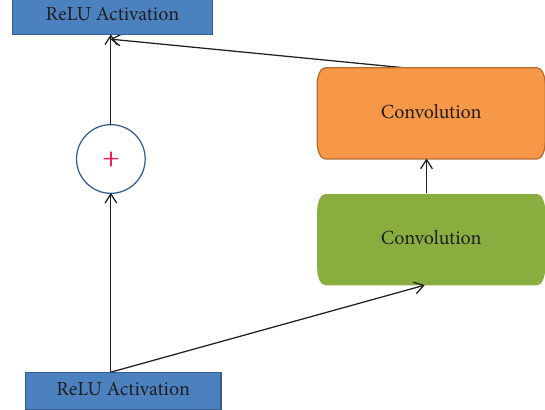
Figure 3: Basic diagram of residual